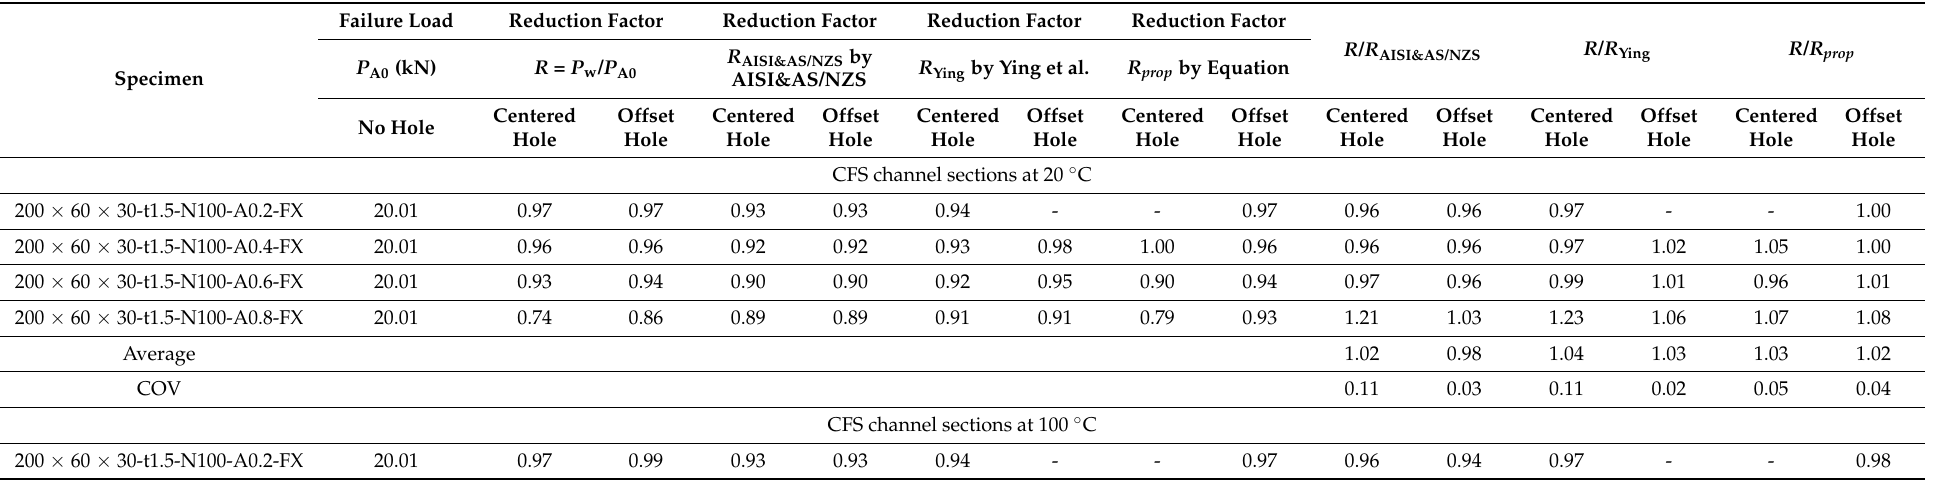
Table 7. Comparison of proposed equations with other methods for sections with fastened